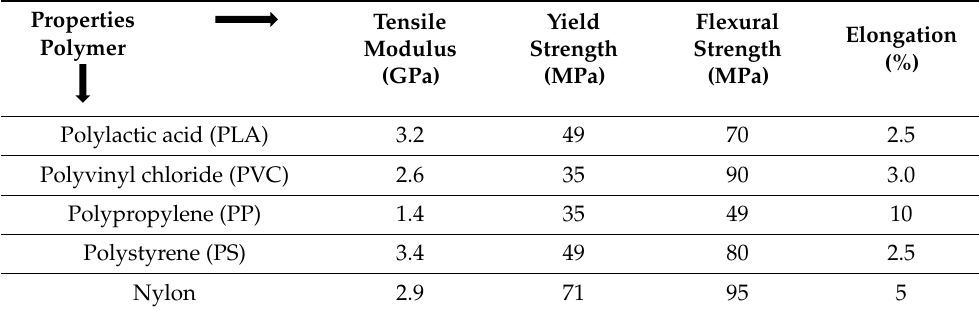
Table 2. Properties’ comparison of PLA with polymers [30].